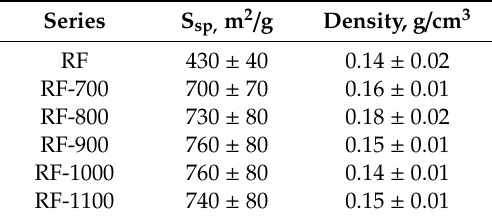
Table 1. Specific surface area (m 2 / g) and bulk density (g / cm 3 ) of RF-aerogels.